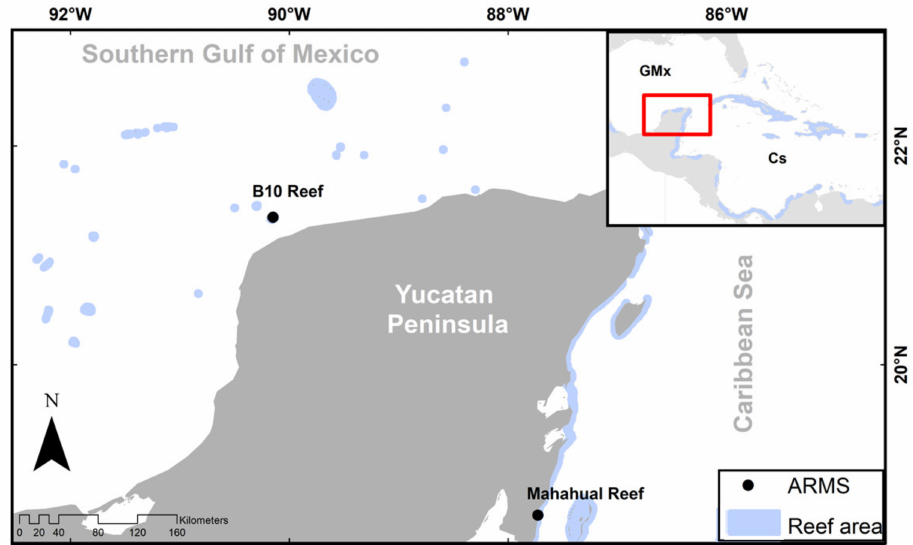
Figure 1. Studied reefs in the Mexican Caribbean sea (Cs) and the southern Gulf of Mexico (GMx) [32], where autonomous reef monitoring structures (ARMS) were